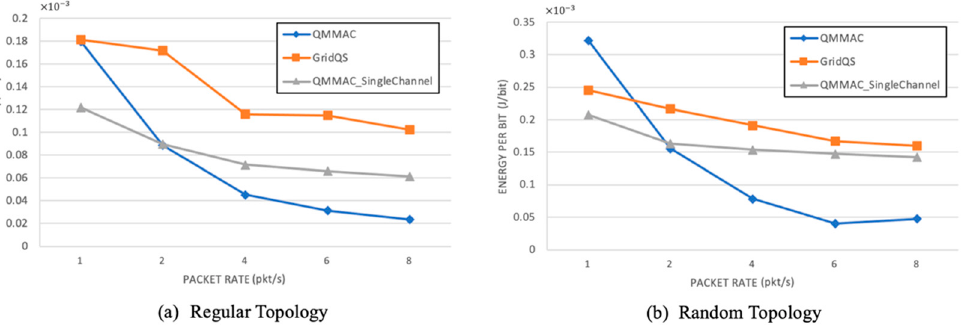
Figure 20. Energy per bit.